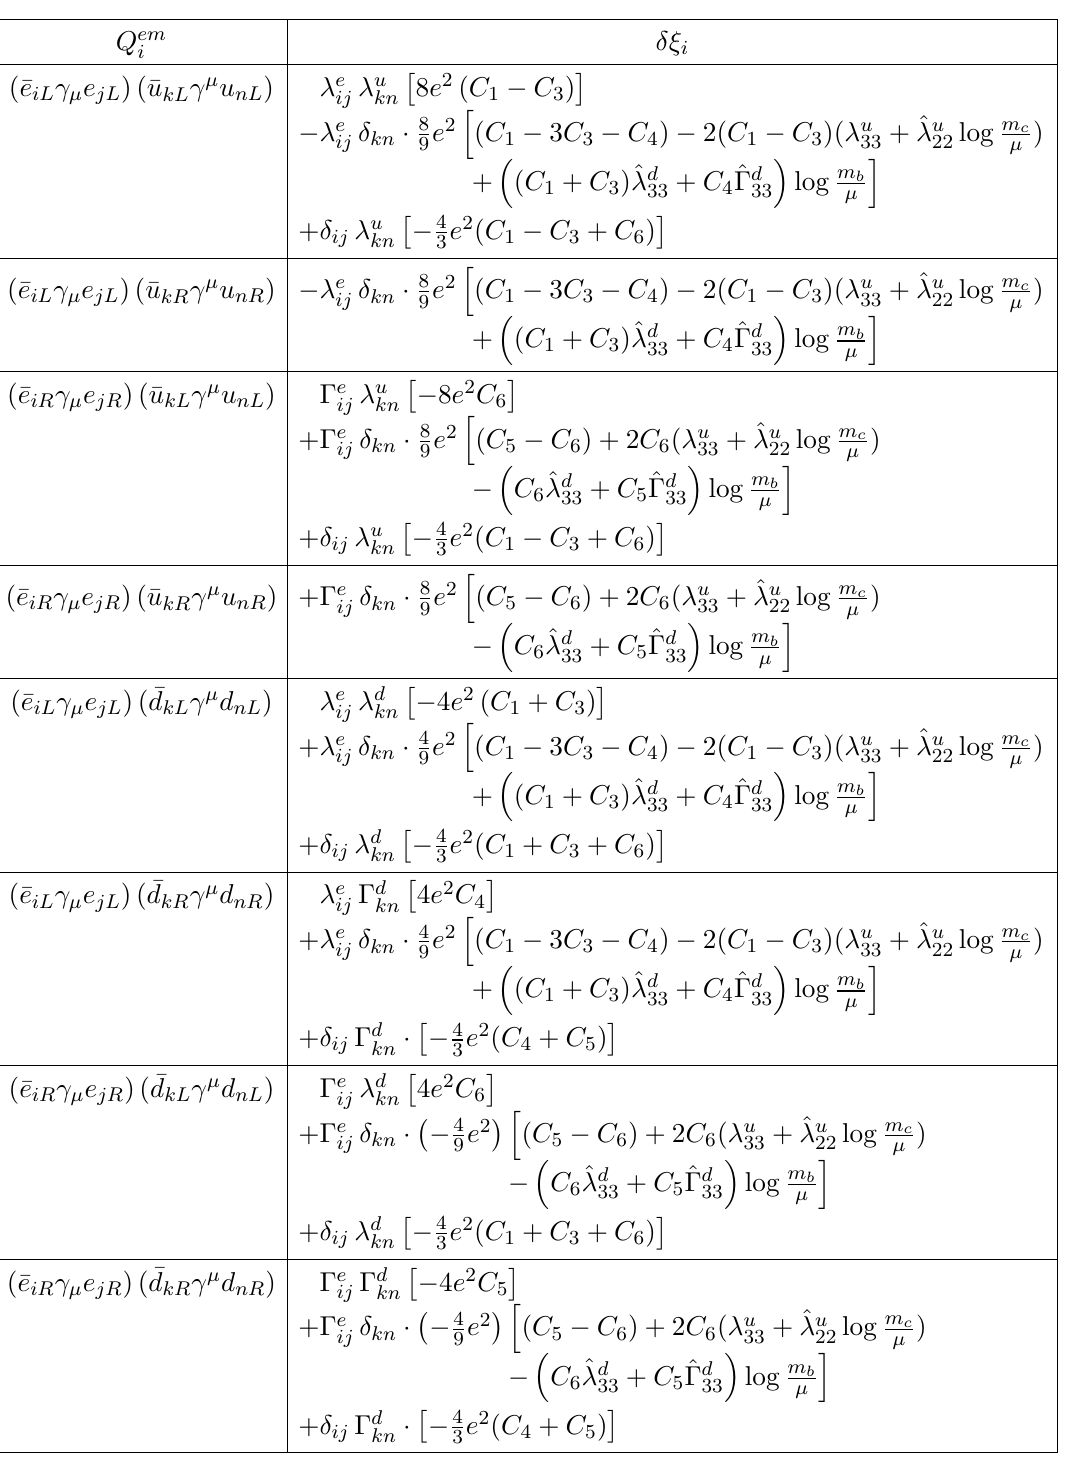
Table 8 . Operators Q em